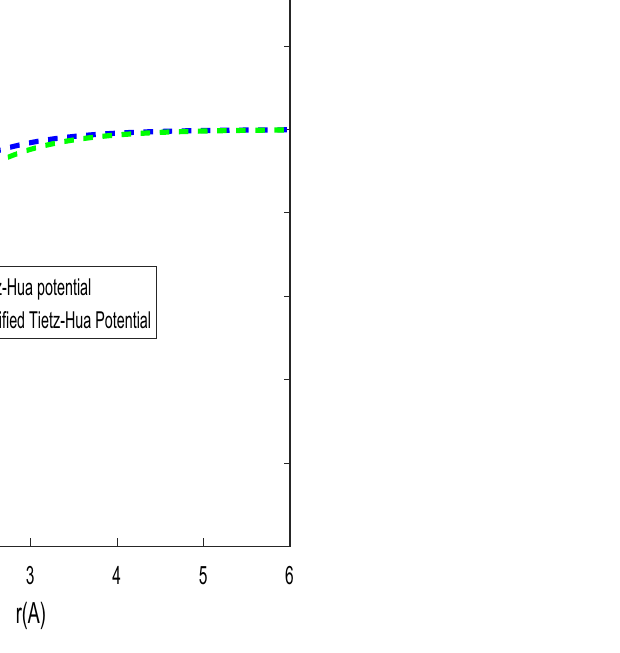
Figure 1. Tietz–Hua and modified Tietz–Hua